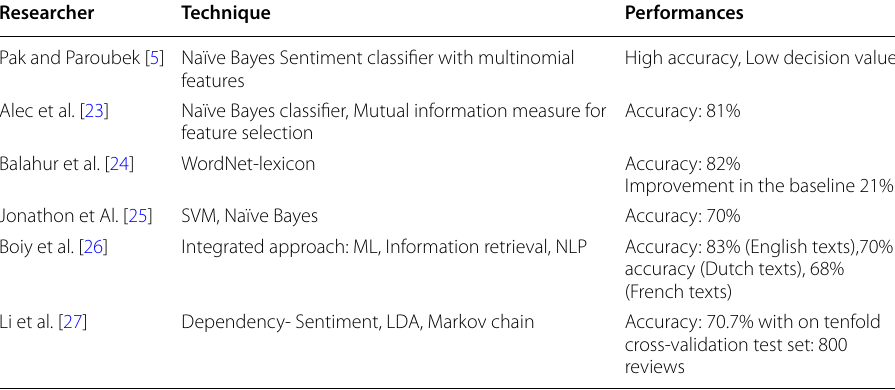
Table 1 Comparison of different approaches in sentiment analysis Researcher Technique